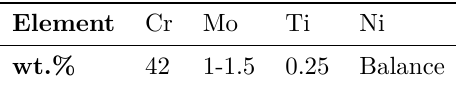
Table 1. Chemical composition of Cr-Ni alloy